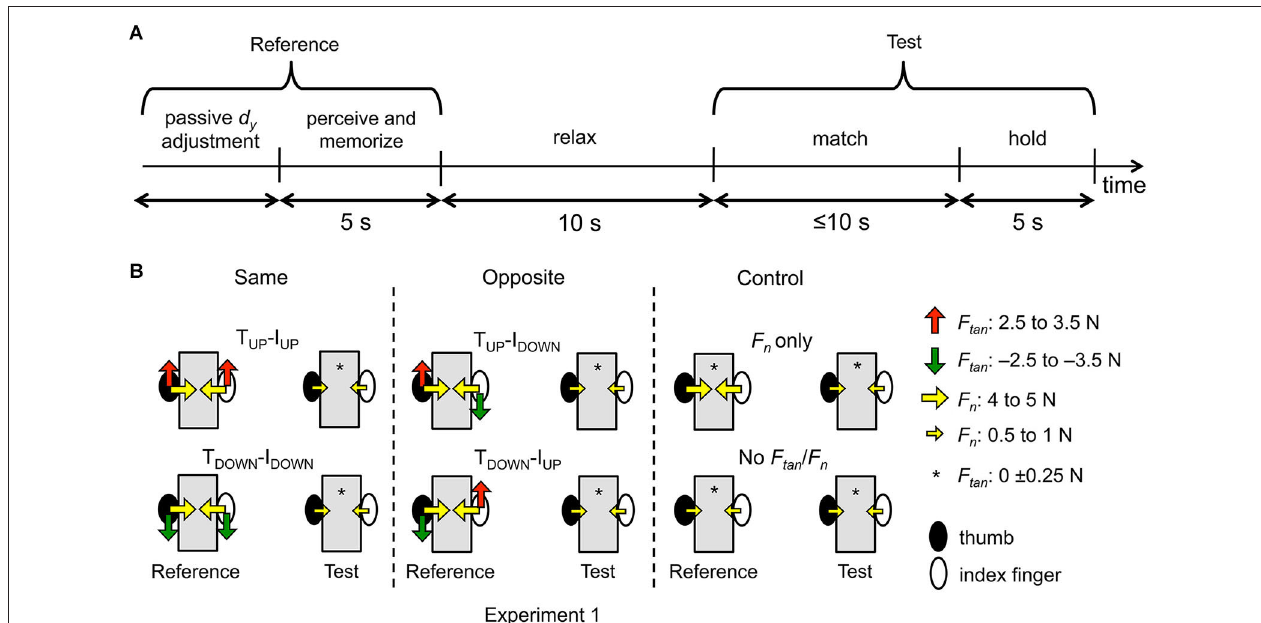
exerted tangential forces either in the same or opposite directions (“Same” and “Opposite”, left and middle column, respectively). In the Same condition, thumb and index finger exerted tangential forces that were both upward or downward (T UP -I UP or T DOWN -I DOWN , respectively). In the Opposite condition, the tangential forces of the thumb and index finger were directed opposite to each other, i.e., either upward and downward (T UP -I DOWN ) or downward and upward (T DOWN -I UP ), respectively. In the Control condition (right column), subjects were asked to exert no tangential force while exerting large or negligible normal forces (“ F n only” or “No F tan / F n ” , respectively). The magnitude of tangential and normal forces was the same across these conditions ( F tan : 2.5–3.5 N, F n : 4–5 N) with the exception of the “No F tan / F n ” condition ( F tan : 0 ± 0.25 N, F n : 0.5–1 N). The test hand in Experiment